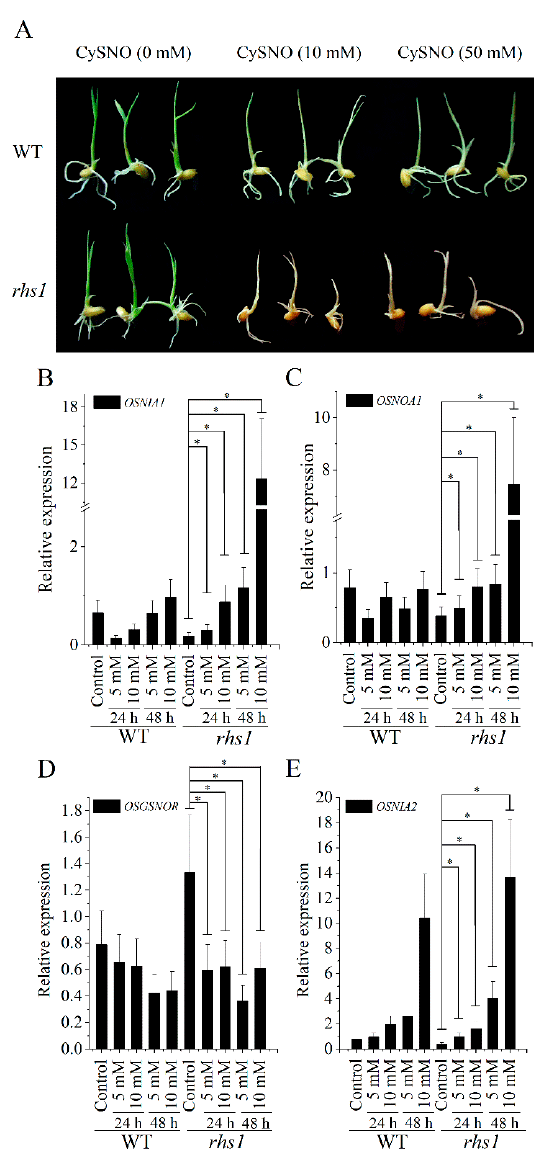
Figure 2. Response of rhs1 seedlings to nitrosative stress. The seedlings of rhs1 tested for their response to nitrosative stress were induced by 10 and 50 mM CysNO ( A ). Expression of rice NIA1 ( B ), NOA1 ( C ), GSNOR ( D ), and NIA2 ( E ) before and after nitrosative stress treatment is shown. Each data point represents the mean of the three replicates. Means were analyzed for significant difference using the Student’s t -test. Error bars represent the standard deviation. Significant differences are represented by an asterisk (*) at p <